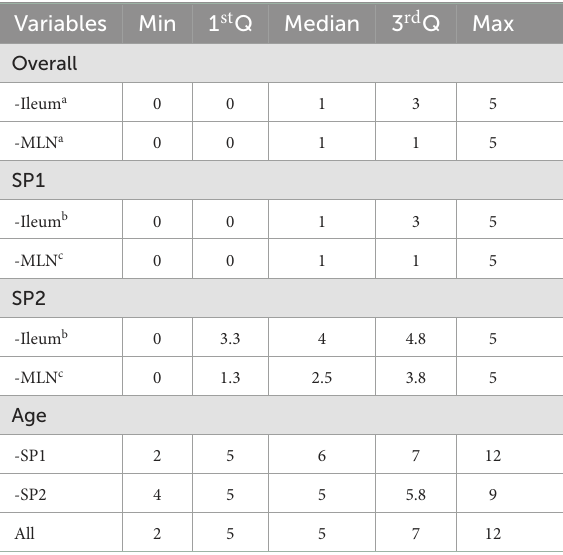
TABLE 3 Descriptive and analytical statistics of histopathology severity score (HSS) comparison across distribution across subpopulation origin, sample types and age.